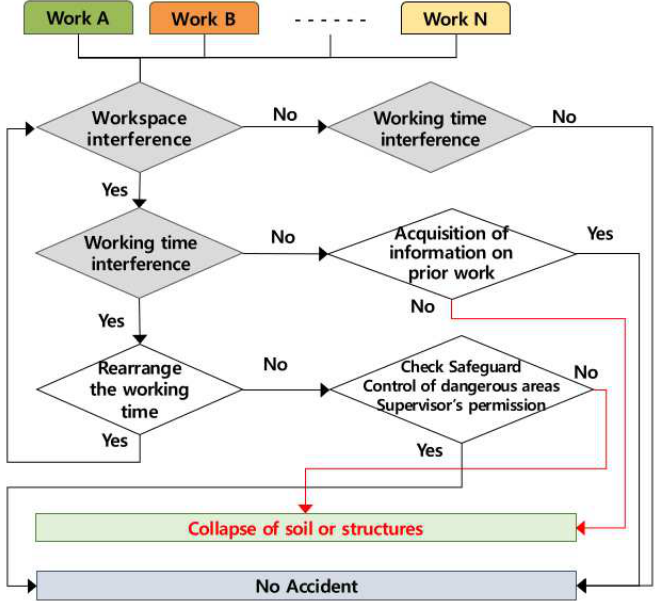
Figure 10. Mechanism of collapse by multiple processes in the workplace (AMMP model—collapse).